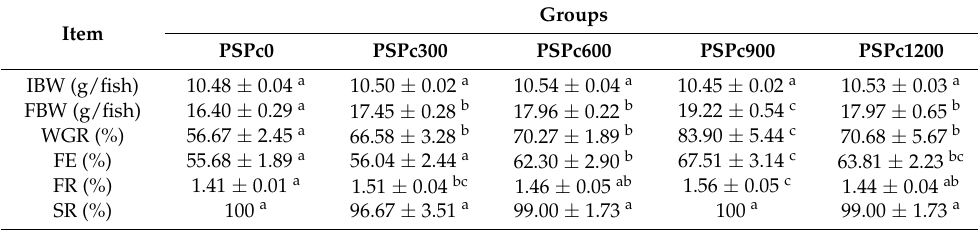
Table 1. The growth performance of juvenile American eel in different PSPc groups.